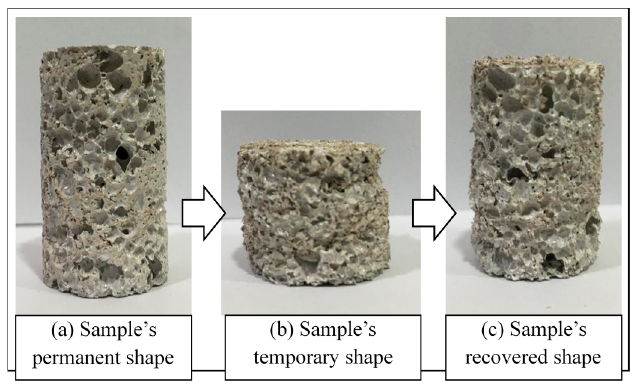
Figure 5. A sample just heated: Compressed to 50%: Regained original